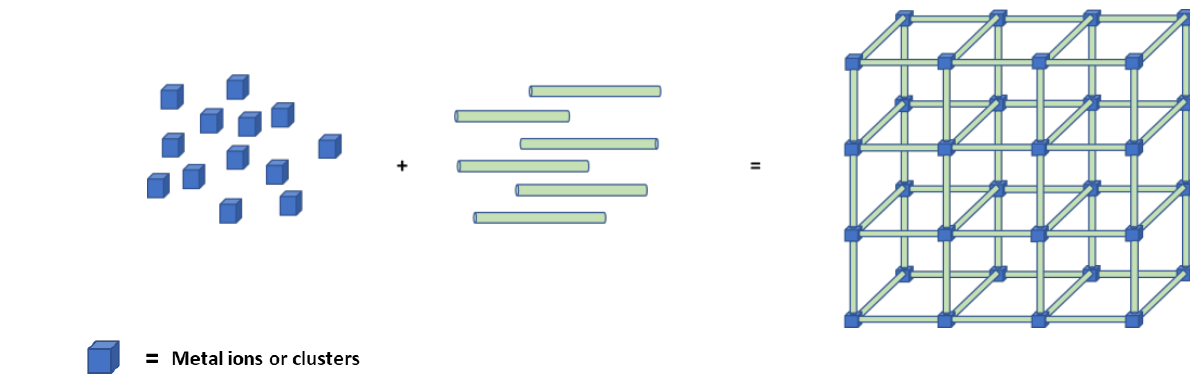
Table 3. BET surface area of HKUST-1 with different